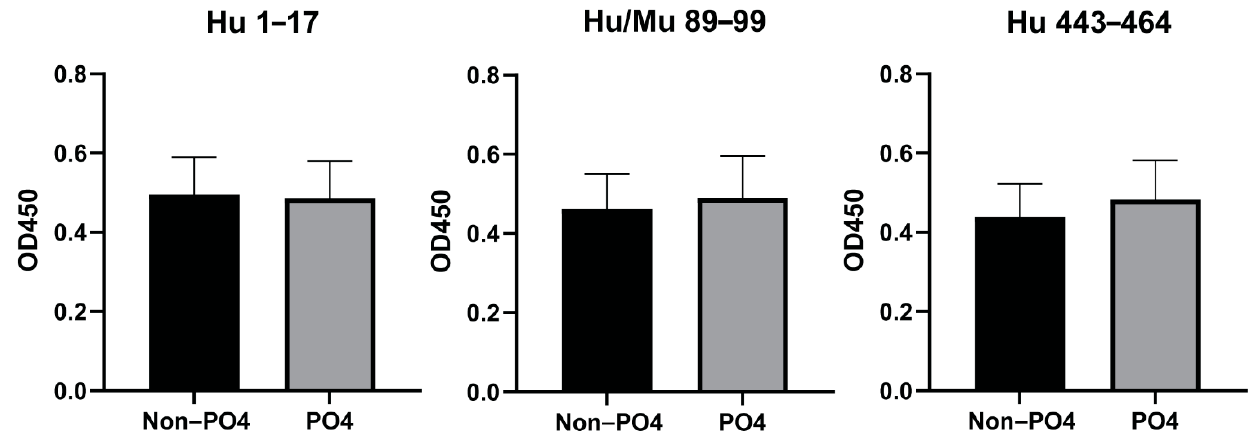
Figure 3. IgA-specific antibodies to individual phosphorylated (PO4) or non-phosphorylated (Non-PO4) epitopes, via indirect ELISA. Using a subset of cohort 2 ( n = 8), plasma samples (diluted 1:20), collected at varied timepoints ( n = 9) were analysed in duplicate. Timepoints include pre-surgery, pre-cycle 2, 5, 8, 10, 11, 12 and following surgery that occurred during chemotherapy treatment. Data are represented as the mean ± SEM and significance was tested using a paired t -test.